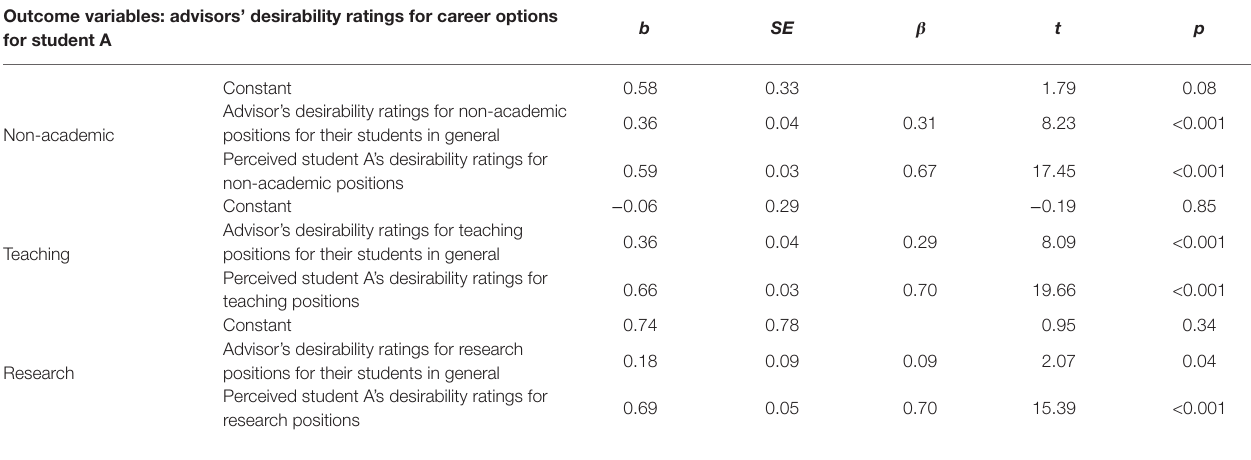
TABLE 7 | Determinants of advisors’ career preferences for student A. Outcome variables: advisors’ desirability ratings for career options for student